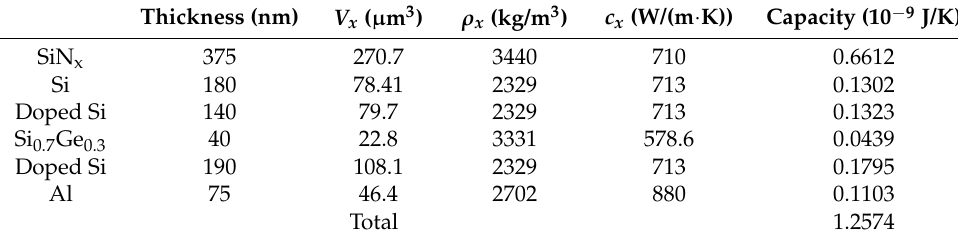
Table 4. The calculation of the micro-bolometer pixel thermal